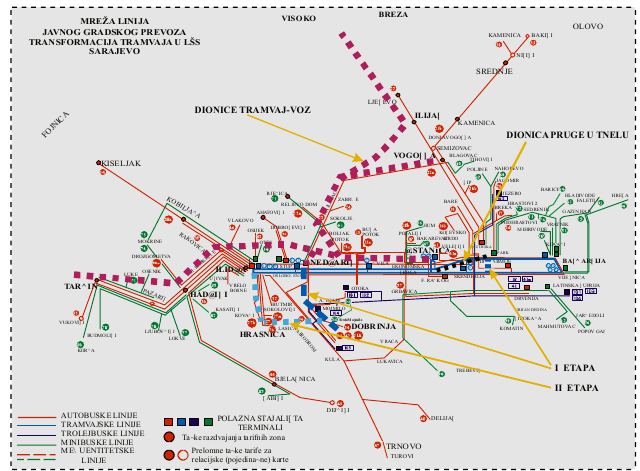
Figure 4. Railway sections by stages of LRT